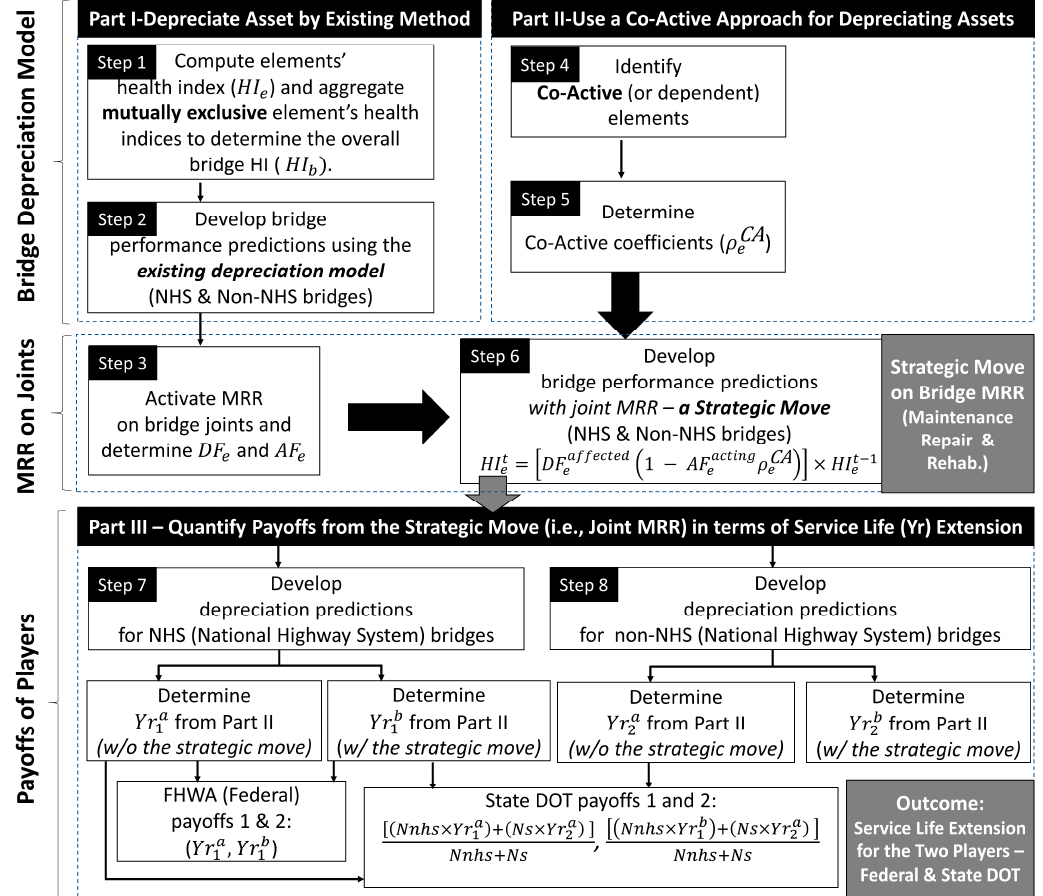
Figure 1. A flow chart showing the methodology.